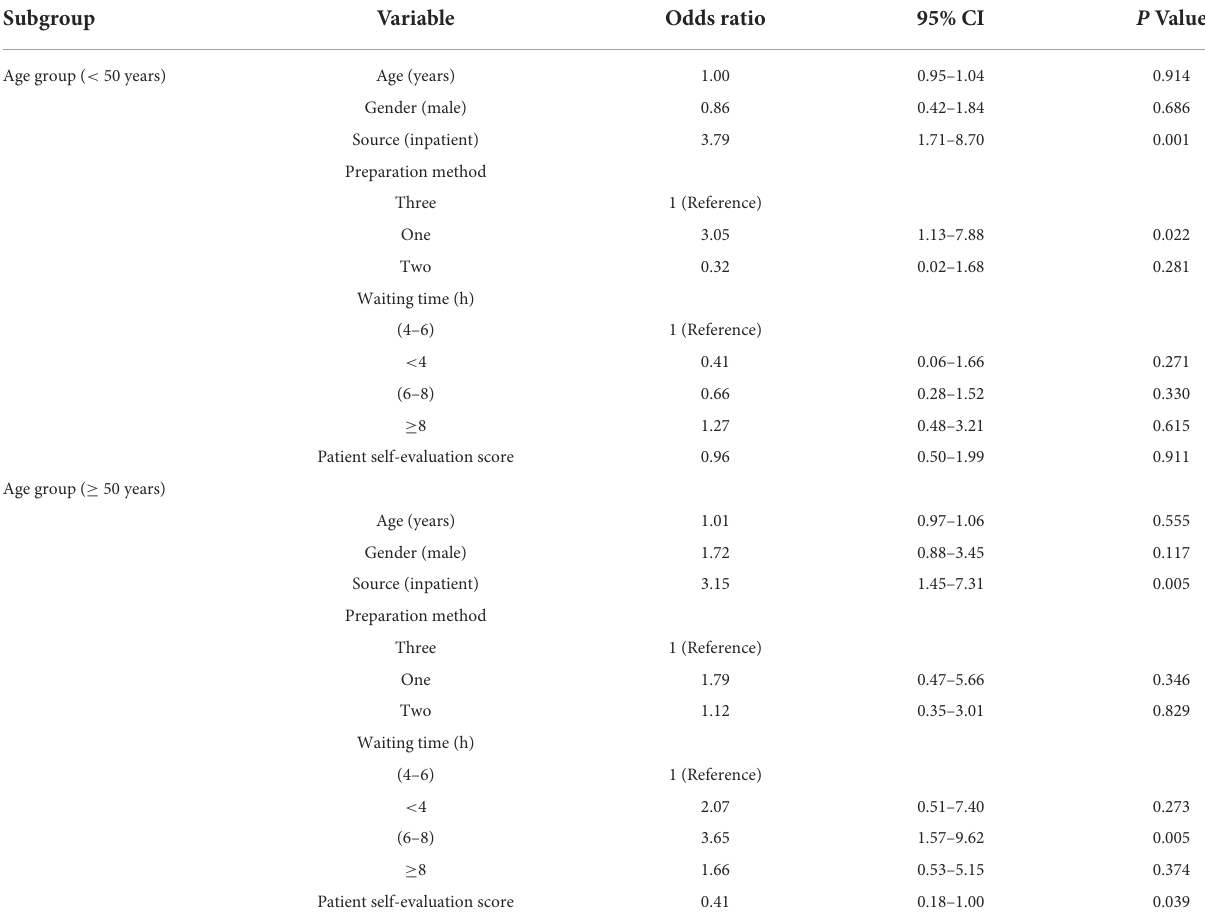
TABLE 3 Multivariate analysis of factors associated with the OBPS segmented by age.